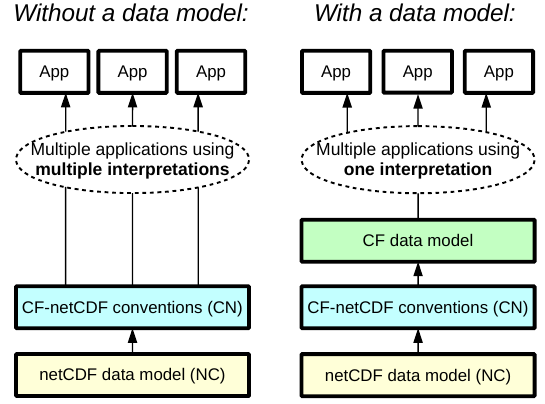
Figure 1. The benefits of having a CF data model. The CF-netCDF conventions (CN) rely on the netCDF data model (NC) and, at present, a software application is forced to make its own interpreta- tion of the CF-netCDF conventions – an interpretation that is likely to be different from that of other applications. The aim of this paper is to propose a comprehensive CF data model that provides a consis- tent interpretation of the conventions, thereby facilitating compati- bility across applications that adopt it. This by no means precludes a variety of software implementations, as there is still considerable flexibility in mapping data model elements onto the data objects needed for a particular